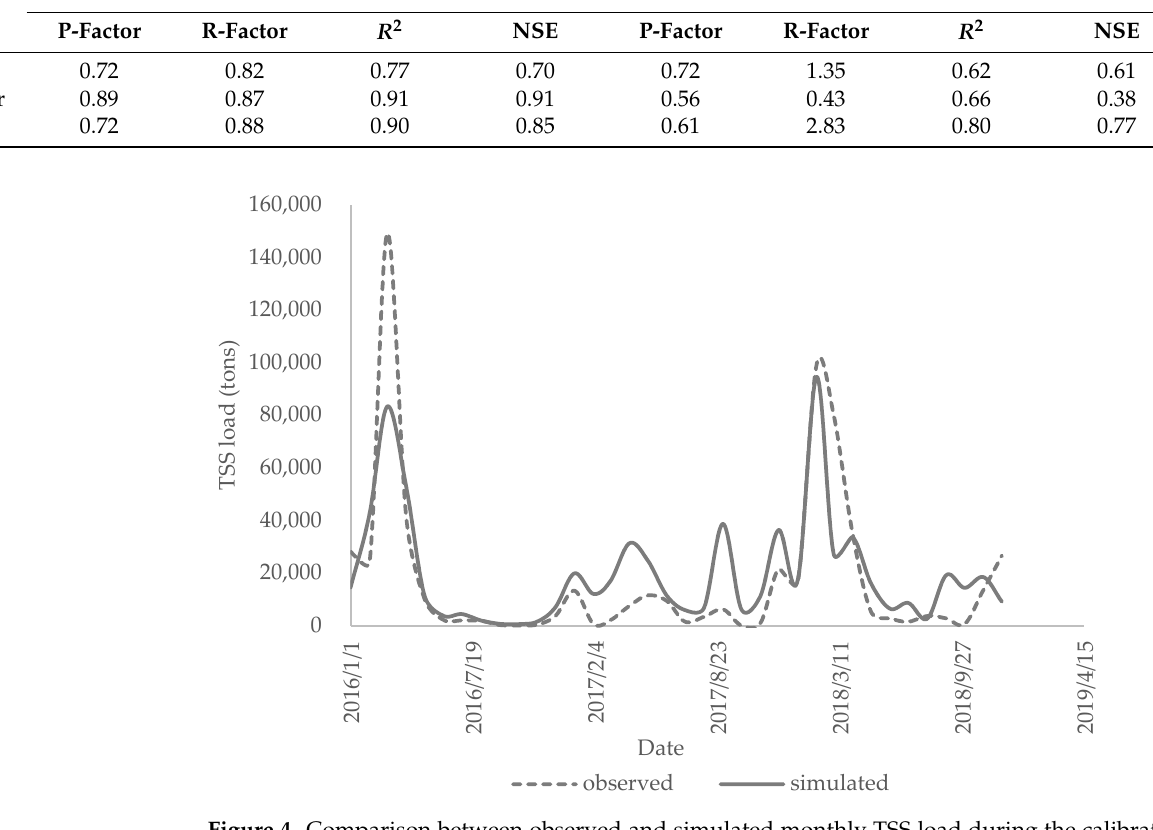
Figure 4. Comparison between observed and simulated monthly TSS load during the calibration